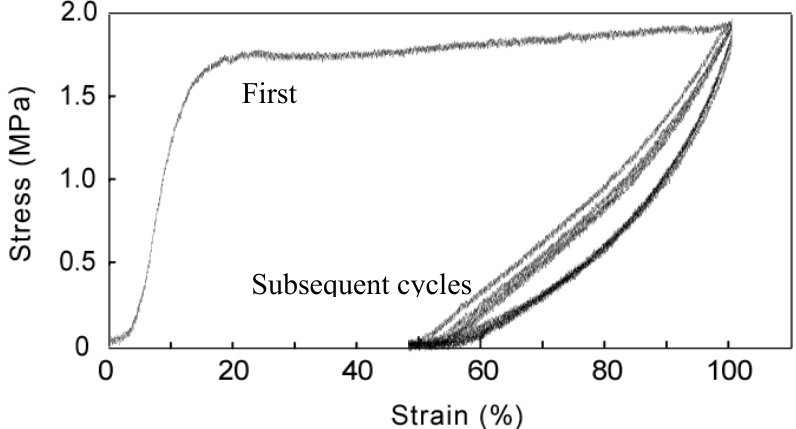
Figure 9. Cyclic stress-strain curves of PHS/M-6 (HM-6 content: 19 mol%).